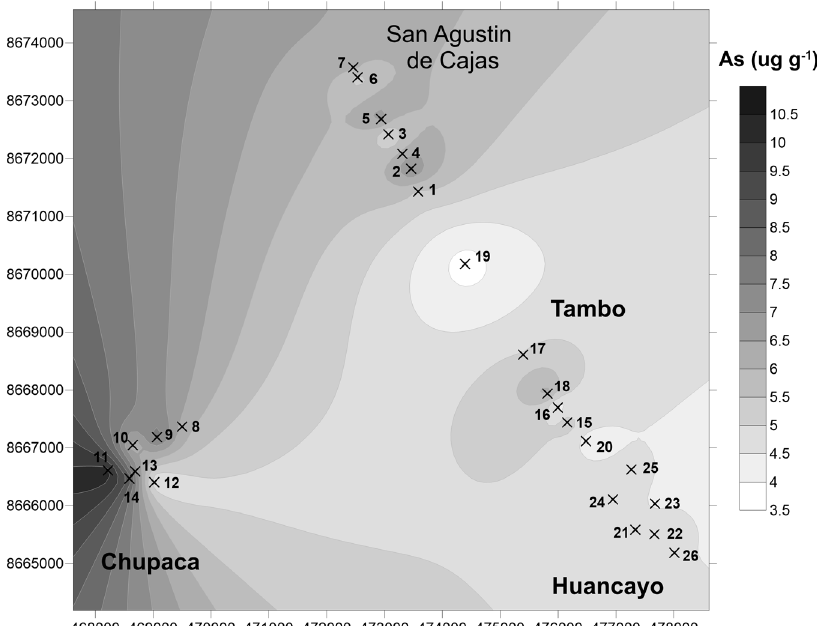
Figure 2. Distribution map of As